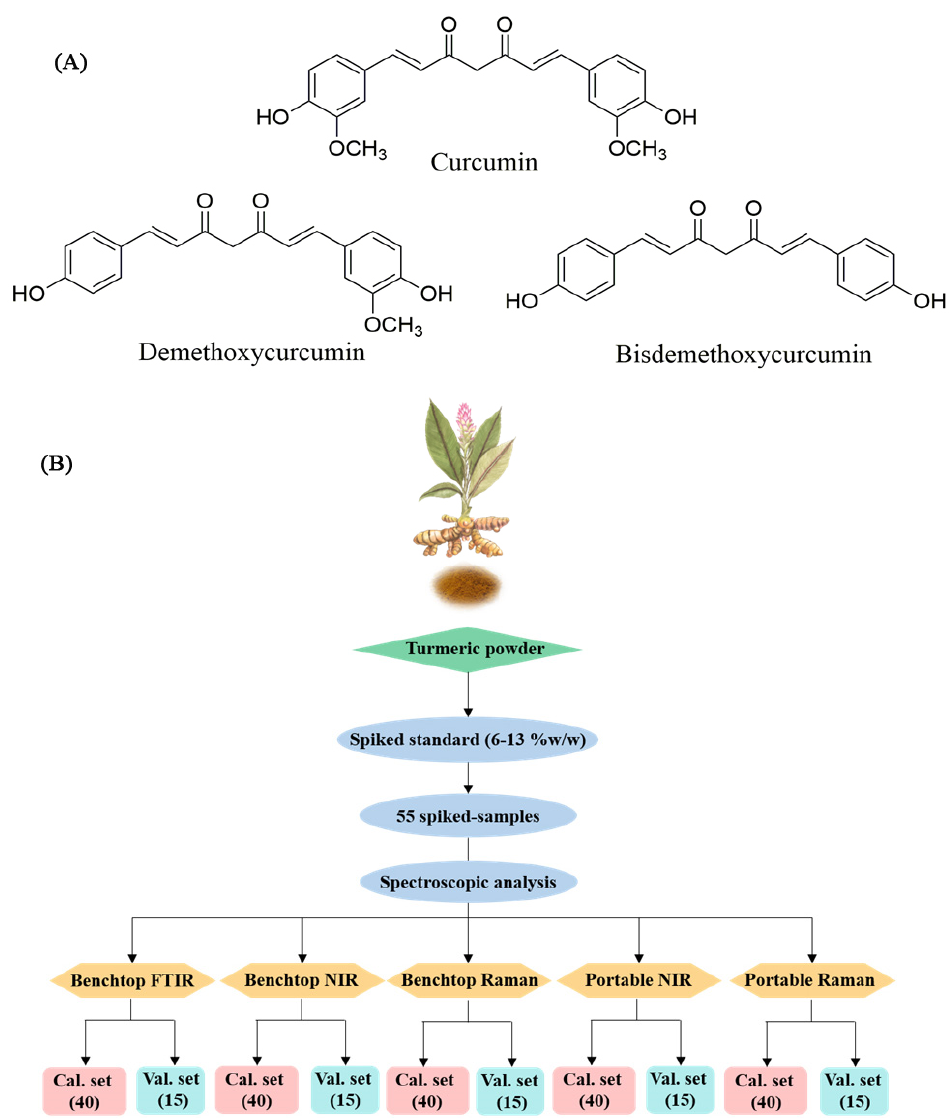
Figure 1. ( A ) Structures of curcumin, demethoxycurcumin, and bisdemethoxy − curcuminand ( B ) di- agram of spiked − samples preparation.